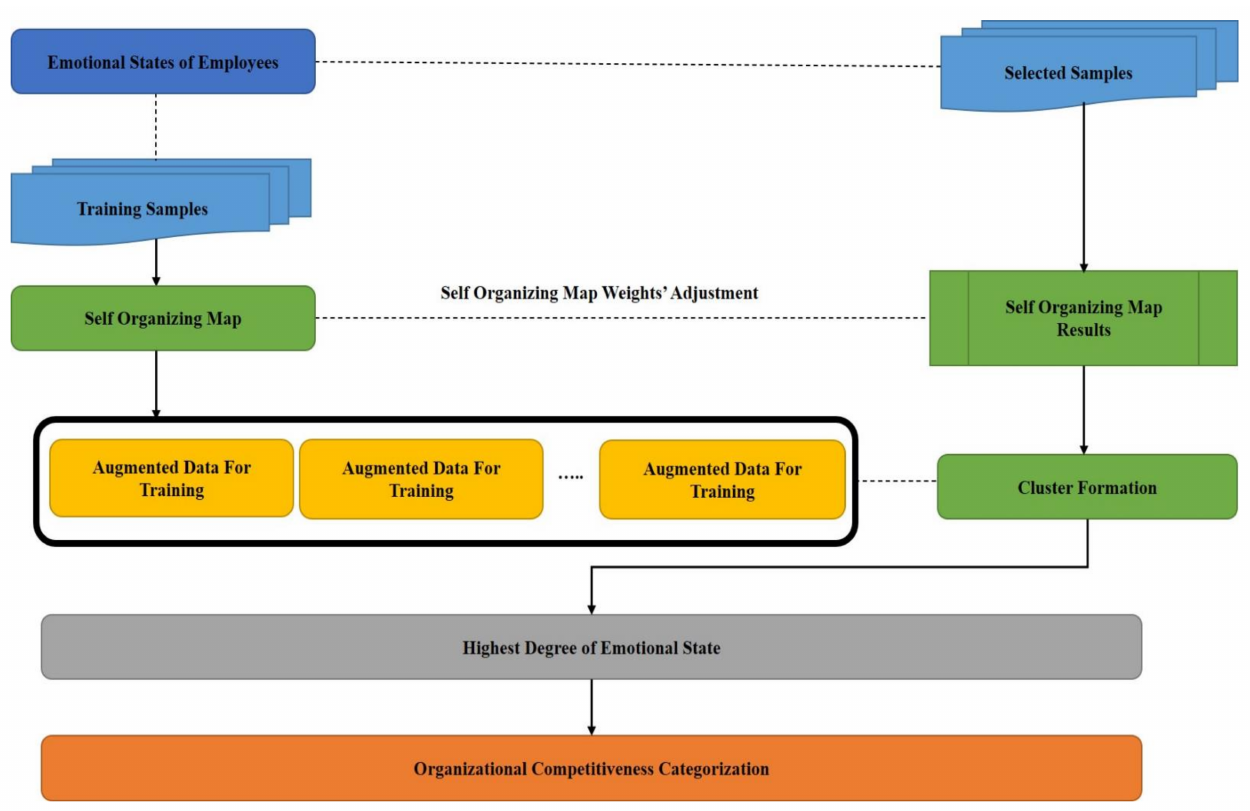
Figure 7. Organizational competitiveness using a self-organizing